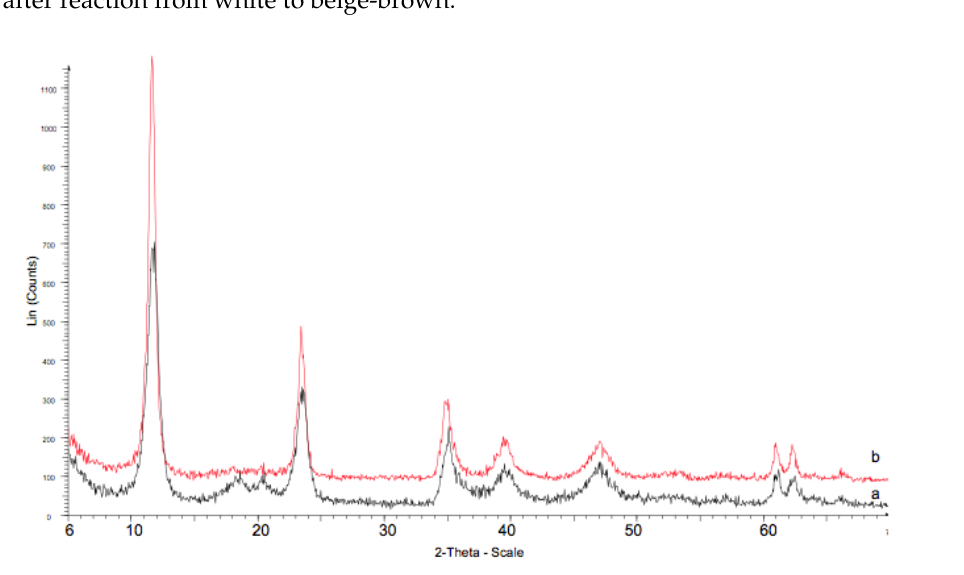
Figure 7. Catalytic life of catalyst HTMgAl3. 318